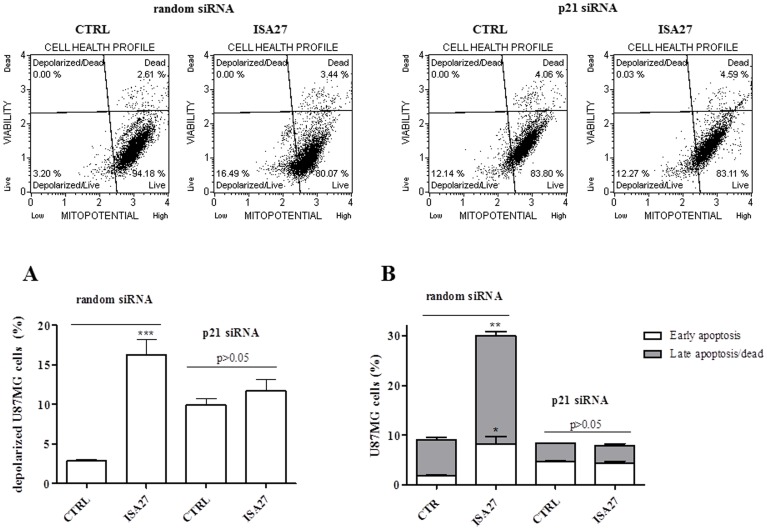
siRNA against p21 made ISA27 unable to induce ΔΨm dissipation and PE.Random siRNA and p21siRNA samples were exposed to a fixed dose of ISA27 (5 µM) or DMSO for 24 h. A) Evaluation of ISA27 effect on the ΔΨm in p21 siRNA samples. The ISA27-treated random siRNA sample showed dissipation of ΔΨm compared to random siRNA sample. The comparison of ΔΨm between p21 siRNA and ISA27-treated p21 siRNA sample did not show statistically significant differences. Upper panel shows representative dot plots of untreated and ISA27-treated random or p21siRNA samples. B) Evaluation of ISA27 effect on PE in p21 siRNA samples. The ISA27-treated random siRNA sample showed a statistical significant increase of early and late apoptosis compared to random siRNA sample. The comparison of early and late apoptosis between p21 siRNA and ISA27-treated p21 siRNA sample did not show statistically significant differences.